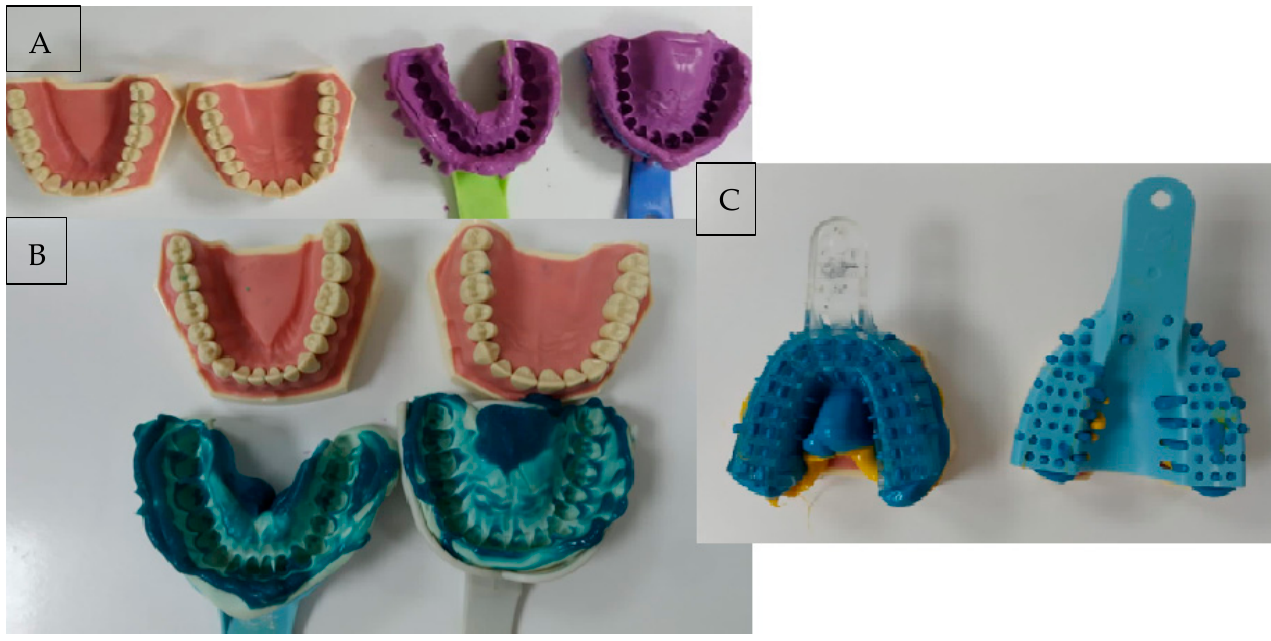
Figure 1. Impressions taken during the study using 3 different materials: ( A ) Alginate; ( B ) Condensing silicone; ( C ) Addition silicone.